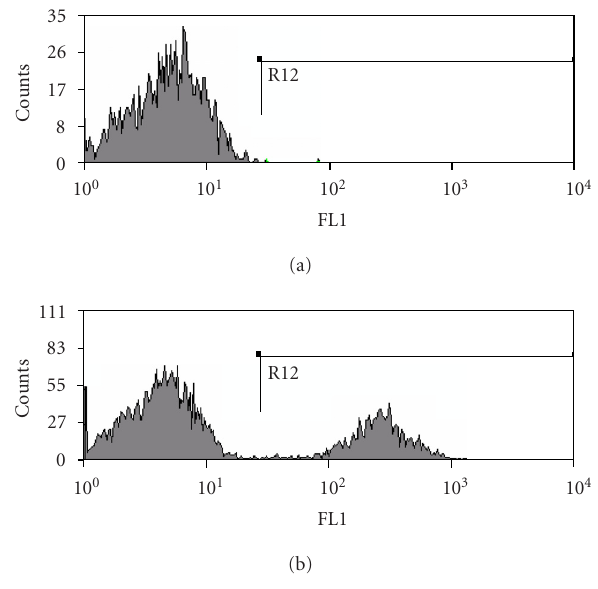
Figure 2. Flow cytometric analysis and isolation of EGFP- labeled cranial NCC. Cell suspensions were prepared from the tissue derived from the cranial region, rostral to the sec- ond branchial arch, of 9 . 5-dpc EGFP-labeled embryos. Cells were subjected to fluorescence-activated cell sorting as delin- eated in the “materials and methods.” Representative histogram (a) shows total population of gated cells. Representative post- sorting histogram (b) indicates EGFP-positive neural crest cells in sector R12. The EGFP-labeled cell population in R12 routinely constitutes approximately 30% of the total gated cells.